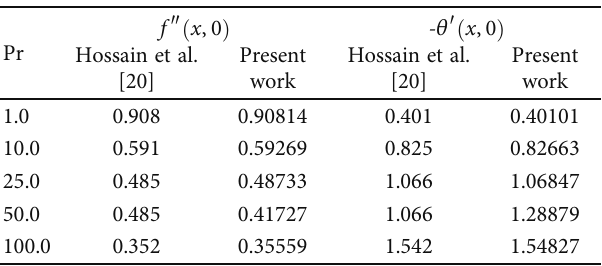
= C μ / k where P ∞ is the Prandtl number and ∞ r p − T Þ is the thermal conductivity variation parameter. ∞